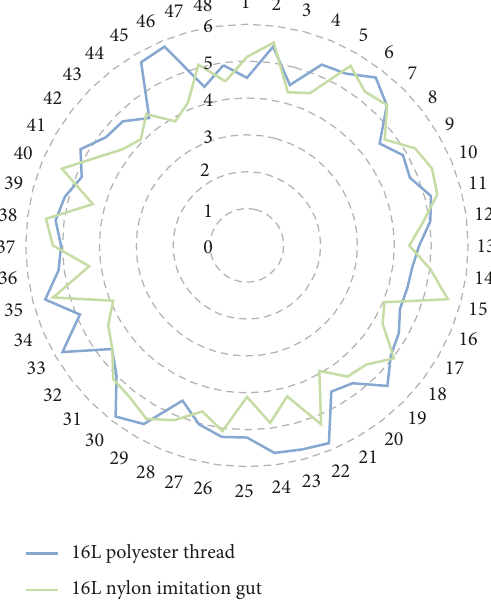
Figure 5: The statistical diagram of the control score of different material Table 3: Racket impact vibration frequencies of different material groups.